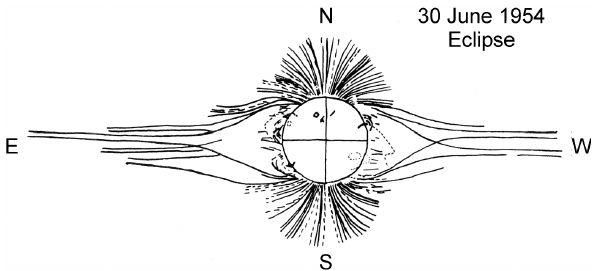
Fig. 9. Observation of the solar eclipse of 30 June 1954 (Vsekhsv- jatsky, 1963) showing the alignment of streamers with the solar